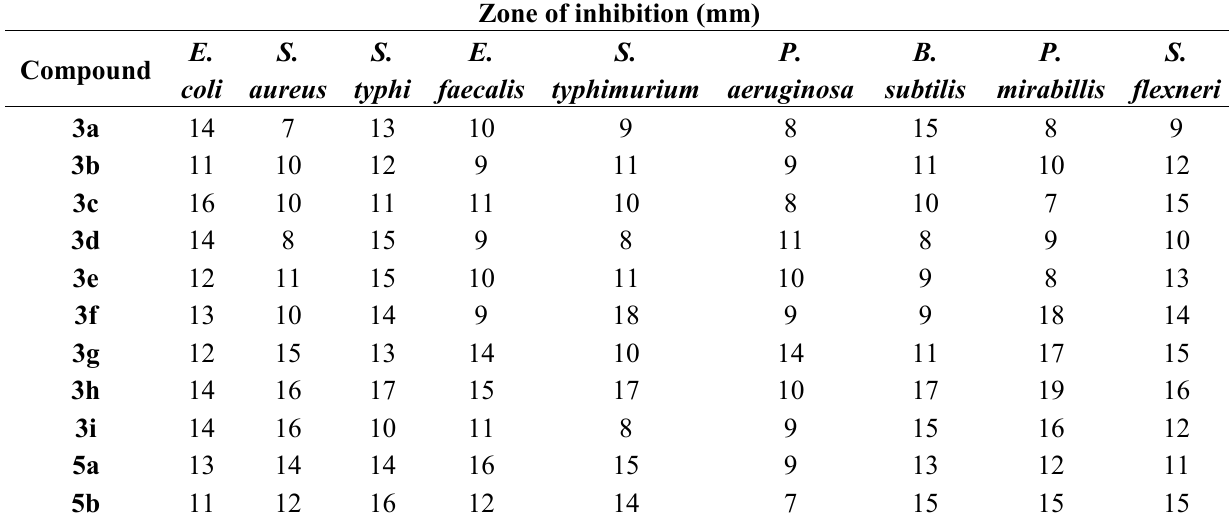
Table 2. Antimicrobial activity of compounds 3a – i and 5a – f (200 µM).